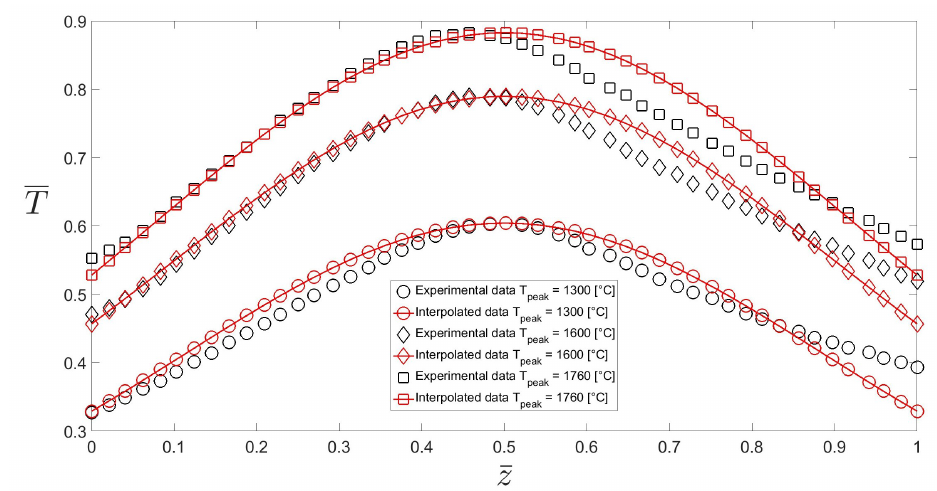
Figure 2. Furnace temperature profiles measured at three different peak temperatures by Voyce et al. [22] and interpolated temperature profiles according to the relation in